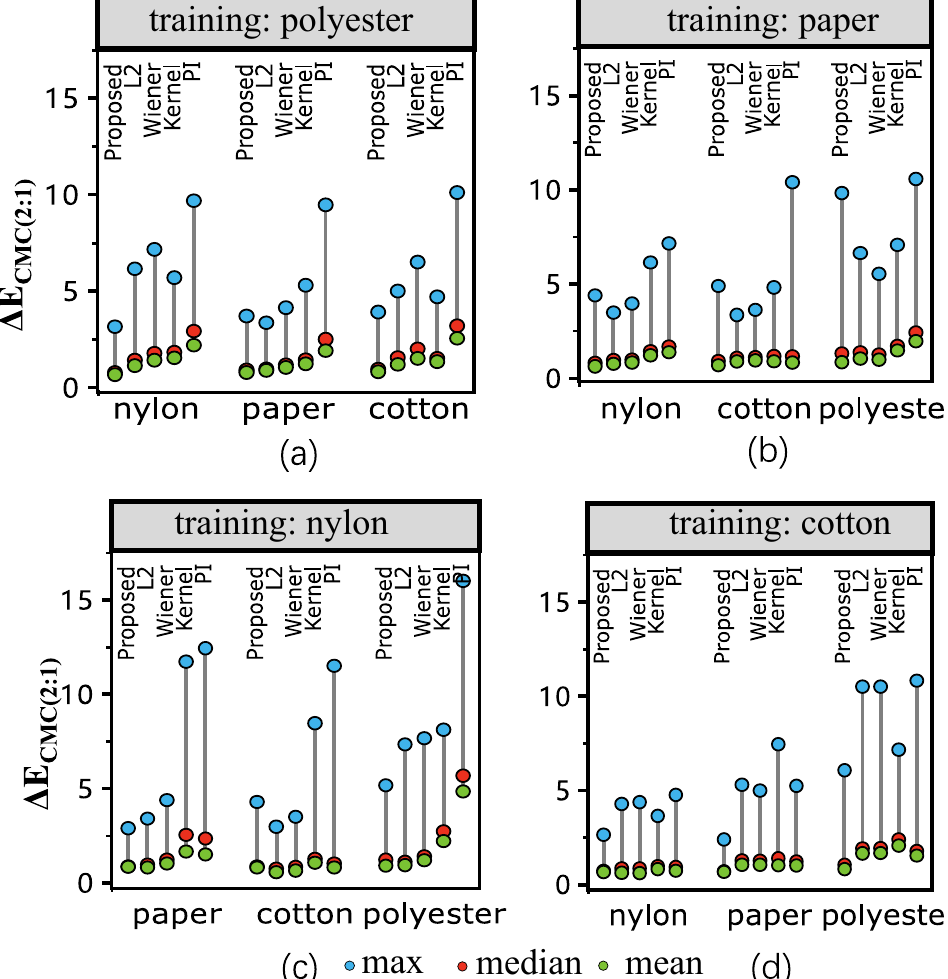
Figure 5. ∆ E results under illumination D65 using different materials as training. “Proposed” refers to our L1-norm penalization method, “L2” refers to the ridge regression (L2-norm penalization), “Wiener” refers to the Wiener method and “PI” refers to the least-square estimation (pseudo-inverse method). Sub-figures ( a – d ) show the results of using polyester, paper, nylon, and cotton as training samples, respectively. Results show that the proposed method consistently outperforms other methods in the color space; more detailed description is provided in the